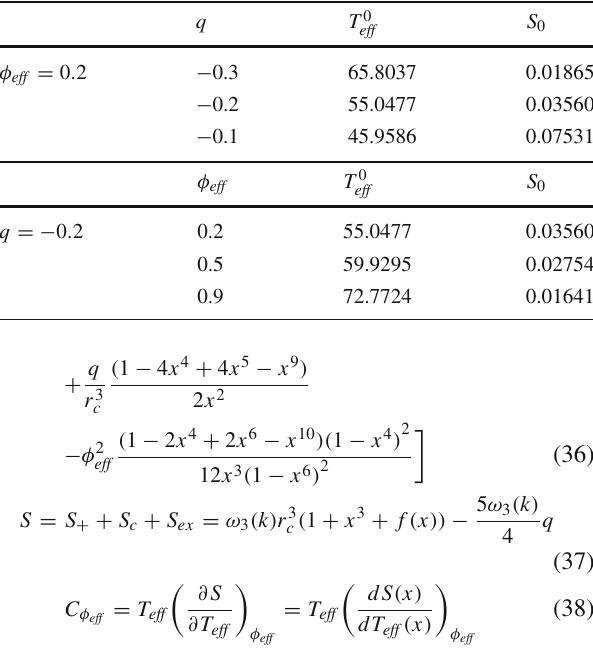
Table 2 Summary of the value of S 0 and T 0 point for different q and e